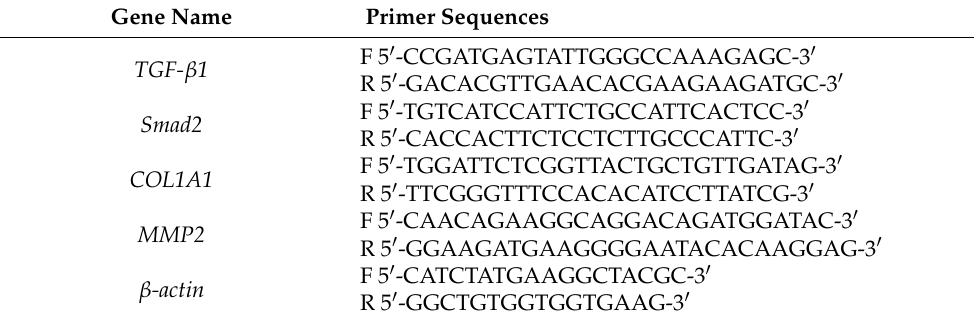
Table 2. Primers for